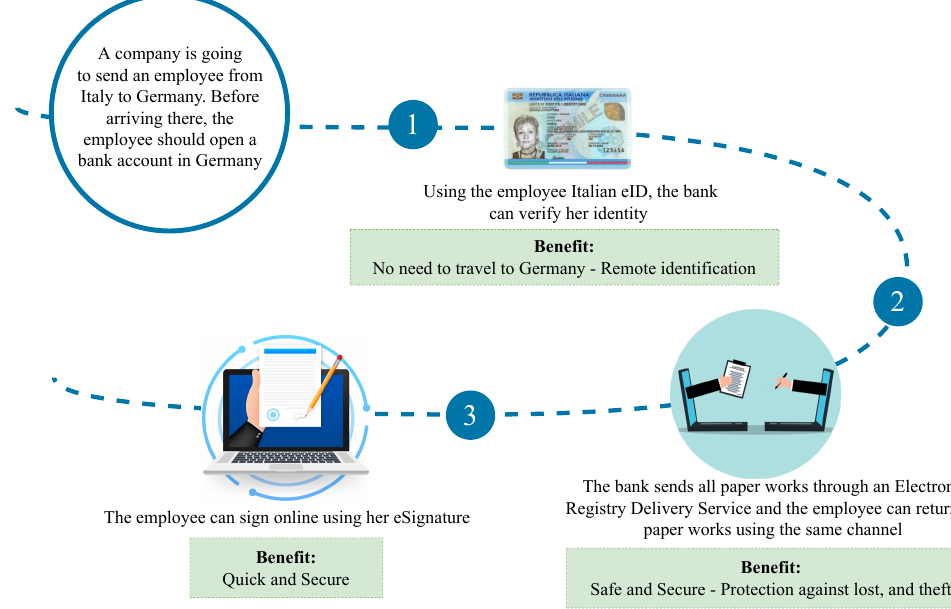
Figure 1. eIDAS in action: opening a bank